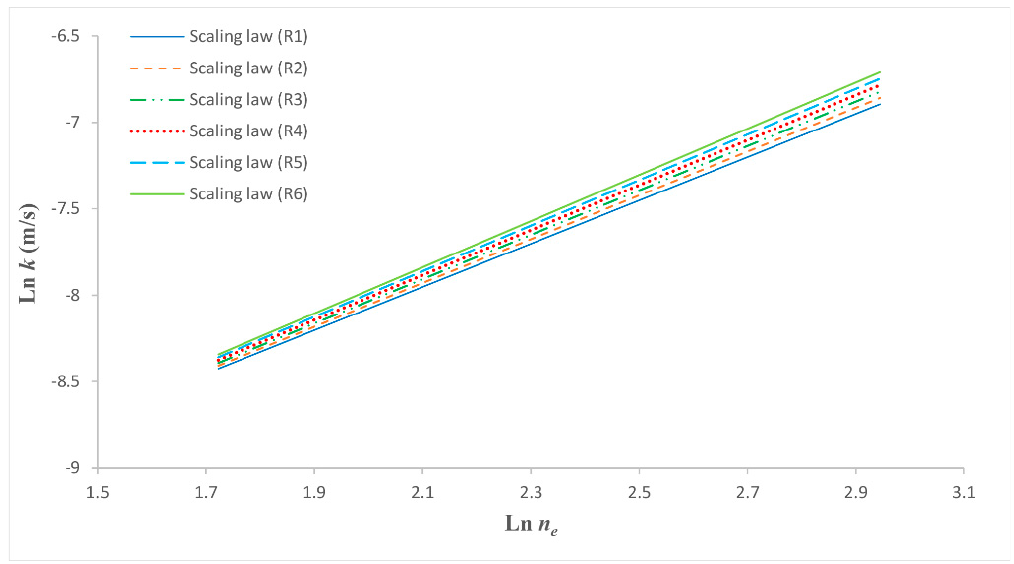
Figure 6. Scaling laws according to Equation (13) for the six fixed values of R .